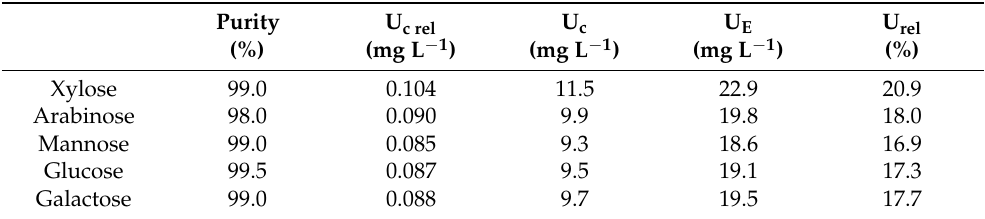
Table 11. Uncertainties of the analyzed sugars.